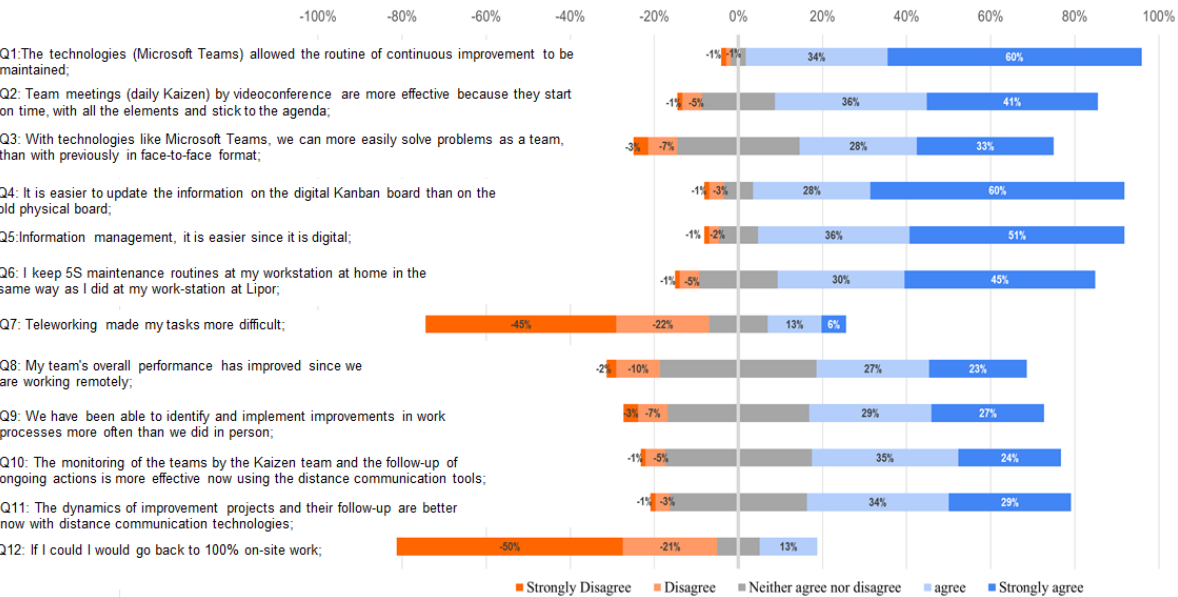
Figure 2. Results regarding the impact of telework on CI